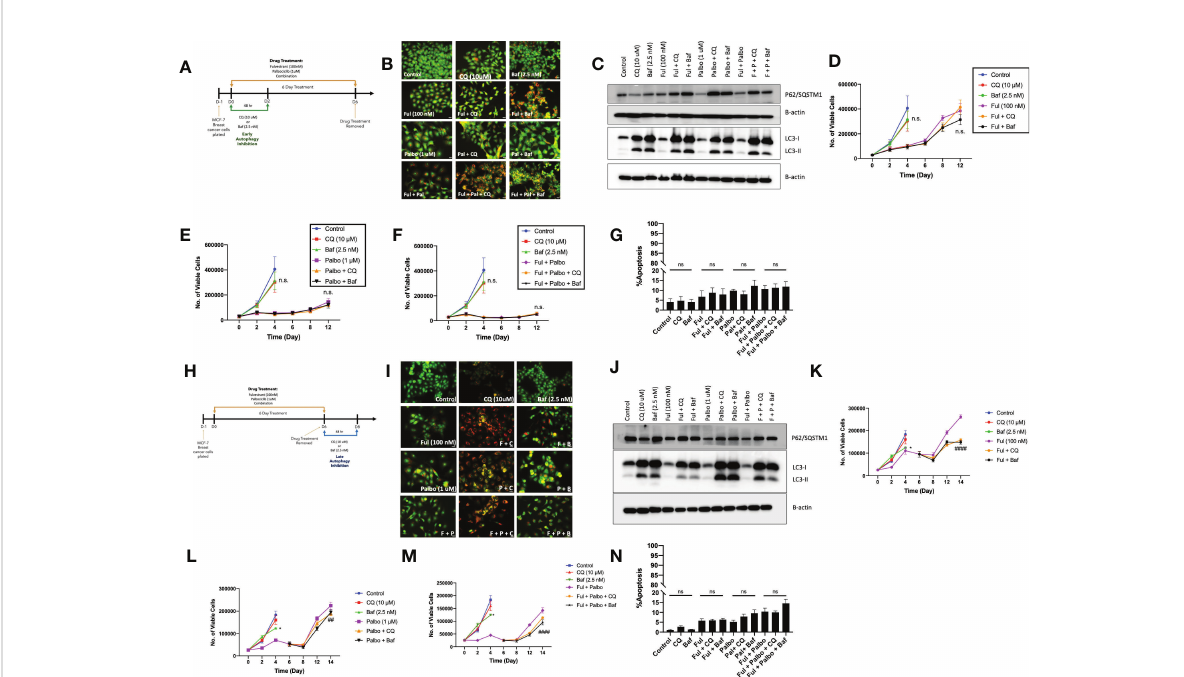
FIGURE 3 Autophagy inhibition does not alter sensitivity to Fulvestrant in combination with Palbociclib in MCF7 cells. Cells were pre-treated for 3 h with either CQ (10 uM) or Baf A1 (2.5 nM). CQ and Baf A1 were given for an additional 48 h, alongside the treatment with Fulvestrant (100 nM), Palbociclib (1 µM) or the combination for 6 days. (A) Schematic of in vitro treatment. (B) Cells were stained with acridine orange on day 3 and imaged using a fl uorescent microscope. All images were taken at the same magni fi cation (scale bar= 200 µm, n=3). (C) Western blot analysis at day 3 assessing accumulation of LC3 I-II and p62/SQSTM1 protein levels. (D – F) Viable cell number was counted via trypan blue exclusion on the indicated days. (G) Apoptosis was measured by annexin V/PI staining. Staining was performed on day 6 and fl uorescence was measured using fl ow cytometry. (H) Schematic of in vitro treatment. Cells were treated with Fulvestrant (100 nM), Palbociclib (1 µM) or the combination for 6 days, drugs were removed, and cells were given an additional 48 h CQ (10 uM) or Baf A1 (2.5 nM). (I) Cells were stained with acridine orange on day 8 and imaged using a fl uorescent microscope. All images were taken at the same magni fi cation (scale bar= 200 µm, n=3). (J) Autophagy inhibition was con fi rmed by western blot analysis assessing accumulation of LC3 I-II and p62/SQSTM1 protein levels. (K – M) Viable cell number was counted via trypan blue exclusion on the indicated days. (N) Apoptosis was measured using annexin V/PI staining. Staining was performed on day 8 and fl uorescence was measured using fl ow cytometry. All images are representative fi elds, blots, or data from at least three independent experiments. *P ≤ 0.05, ##P ≤ 0.01, and ###P ≤ 0.001, ns (not signi fi cant) indicate statistical signi fi cance of each condition compared to Fulvestrant, Palbociclib or the combination of Fulvestrant and Palbociclib as determined using two-way ANOVA with Sidak's post hoc